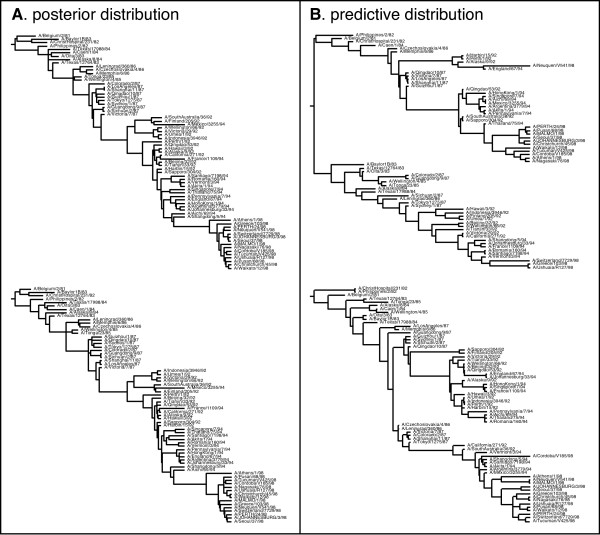
Posterior and posterior predictive genealogies of human influenza A virus. (A) A sample of two trees from the posterior distribution of the human influenza A virus data set. (B) The two matching trees simulated for the predictive distribution of the human influenza A virus data set. Obvious differences between the posterior and predictive trees are the shorter tree length and absence of deep splits in the posterior trees.